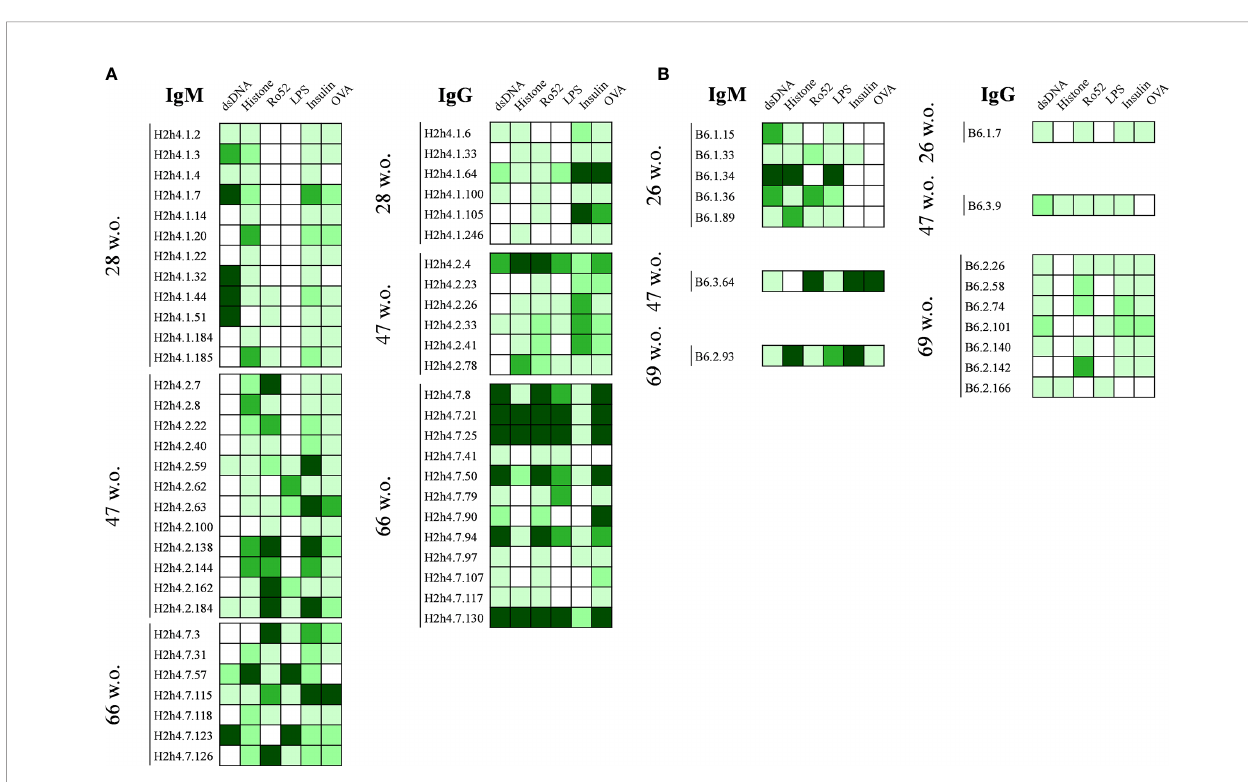
FIGURE 4 | Polyreactivity pro fi le of antibodies derived from NOD.H-2 h4 and C57BL/6J mice. Heat maps showing the antibody binding to a panel of selected antigens (dsDNA, H1, Ro52, LPS, Insulin and OVA). Data of hybridomas derived from NOD.H-2 h4 (A) and C57BL/6J (B) are shown. Color intensity is proportional to the reactivity level measured by ELISA, with darker green indicating high binding and light green showing moderate and low binding (white: no